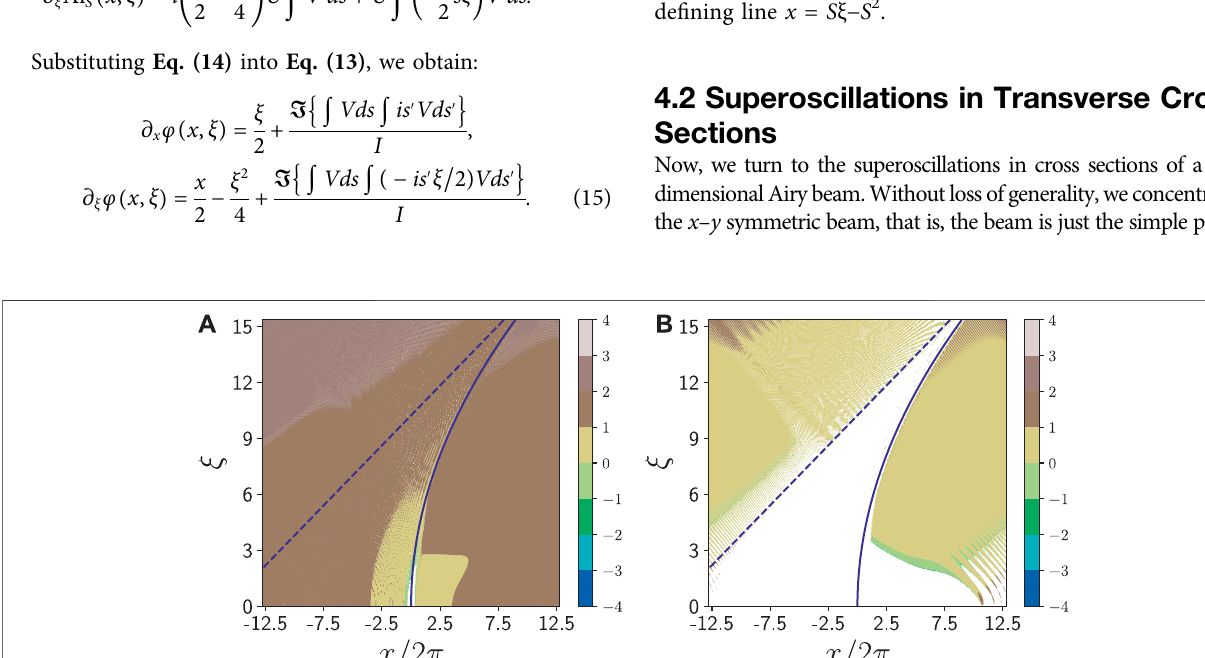
FIGURE 2 | Density plots of the local phase gradients: a, log 10 ( white, the local wave number is smaller than the corresponding wave number. The de fi ning line and the parabola are plotted in blue.